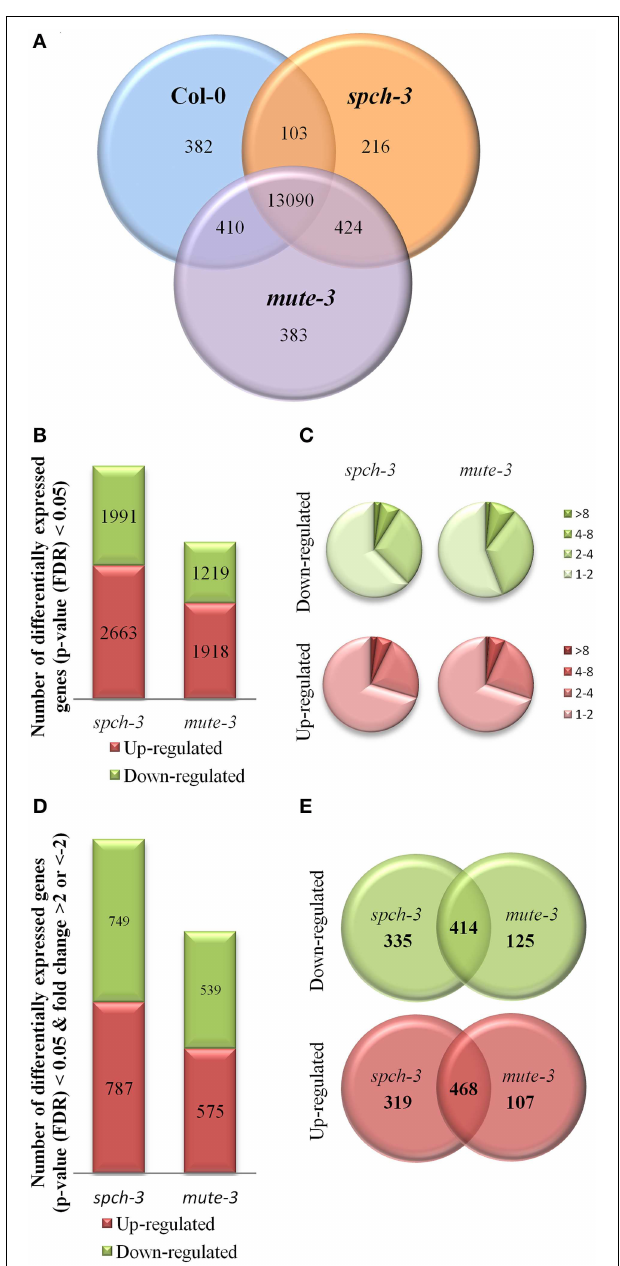
FIGURE 2 | Comparative transcriptomic analysis of spch-3 , mute-3, and Col-0 cotyledons. (A) Venn diagram showing the intersection of all genes expressed in each genotype (MAS5-present call in at least two biological replicates in the array). (B) Genes differentially expressed in each mutant with respect to Col-0 (LIMMA FDR < 0.05) and (C) their distribution by fold-change difference. (D) Genes differentially expressed with a fold-change > 2 or < –2 in each mutant, compared to Col-0 and (E) Venn diagrams showing their intersections. Transcripts correspond to three independent replicates of RNA extracted from 21dpg